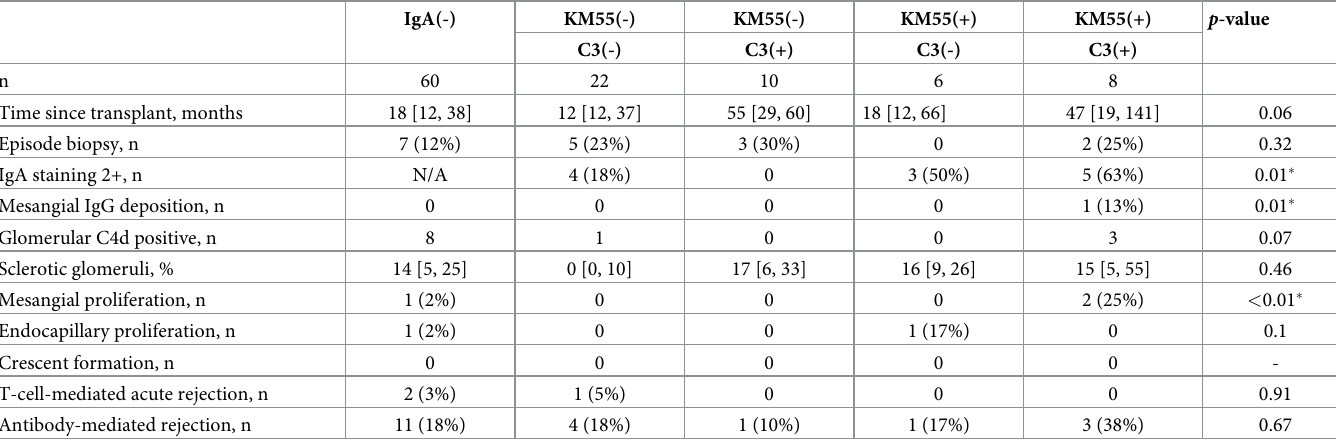
Table 3. Pathological characteristics of allograft biopsies in the subgroups.